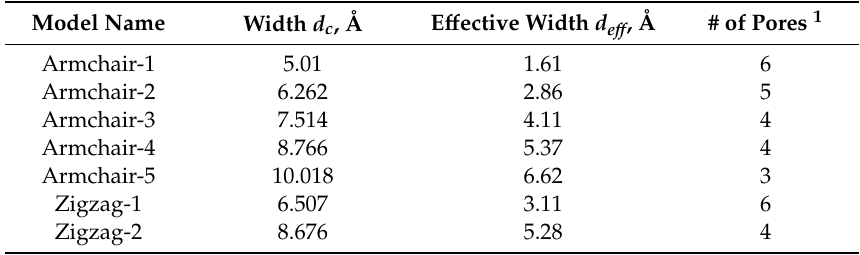
Table 1. Design of the model nanoporous membranes considered in the study.